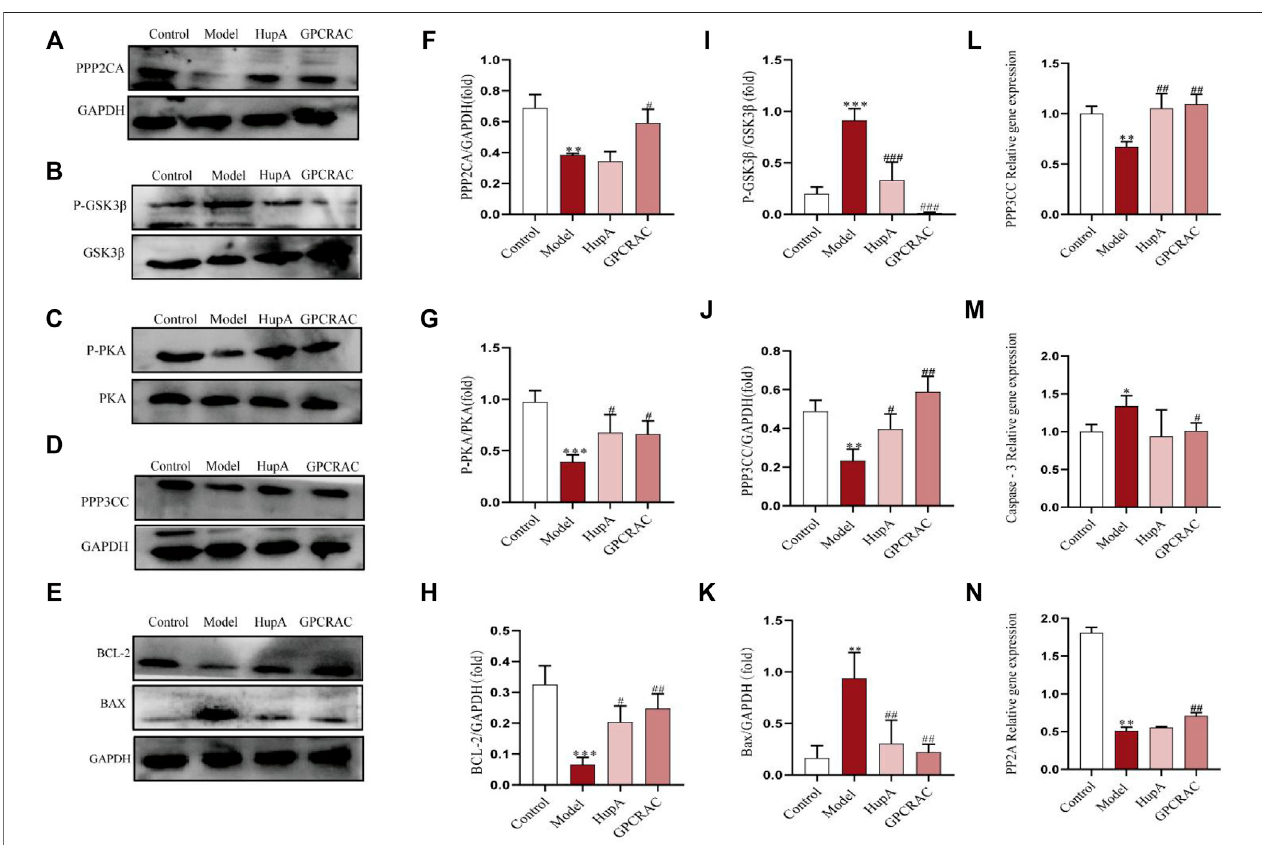
FIGURE 9 | RT-qPCR and WB veri fi ed the signi fi cantly changed proteins. Representative images (A – E) and the protein levels of PPP2CA, GSK3 β , PRKACA, PPP3CC, BCL-2, Bax in hippocampus tissues from mice were measured by Western blotting respectively ( n = 3) (F – K) ; Relative mRNA expression of PPP2CA, PPP3CC and Caspase-3 in hippocampus tissues were detected by real time-PCR analysis respectively ( n = 3) (L – N) ; Data were expressed as mean ± SE, * p < 0.05, ** p < 0.01 and *** p < 0.001 compared to the control group; # p < 0.05, ## p < 0.01 and ### p < 0.001 compared to the scopolamine-treated group ( n = 3).